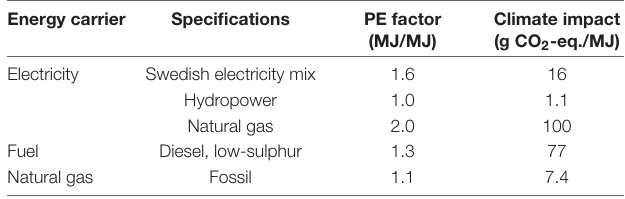
TABLE 1 | Primary energy (PE) and climate impact factors for different energy carriers. 1 Energy